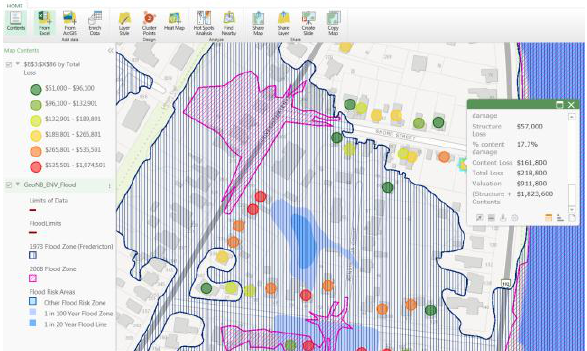
Figure 4. ER 2 results, visualized in MS Excel, Esri Maps